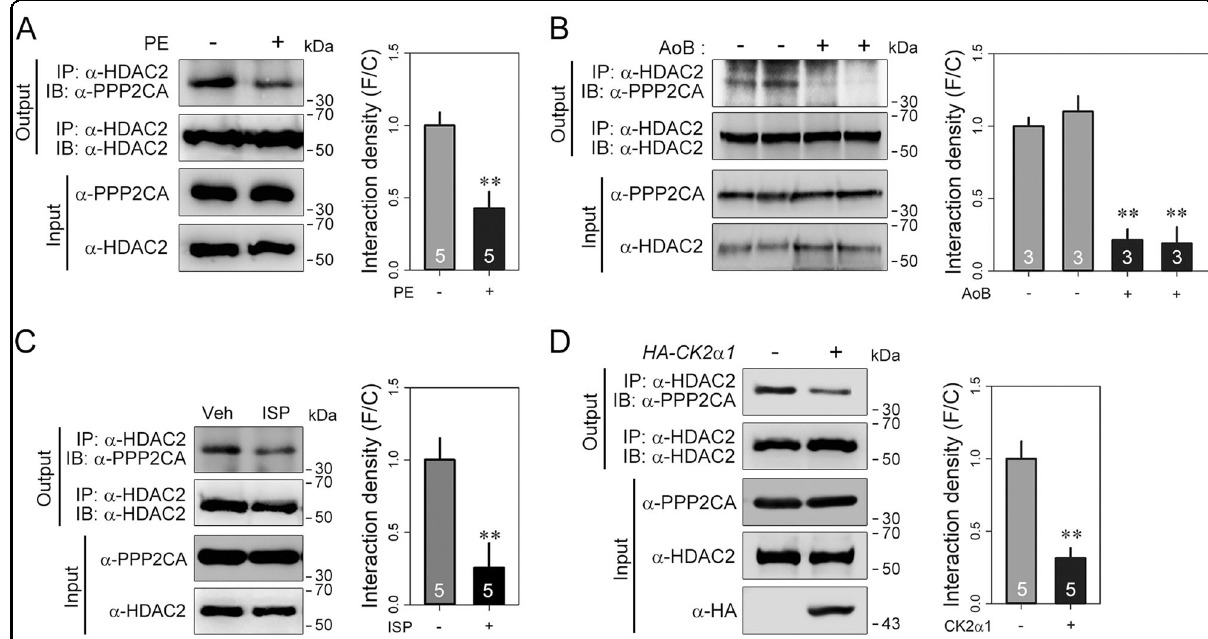
Fig. 3 PPP2CA dissociates from HDAC2 in response to hypertrophic stimuli. The binding of PPP2CA to HDAC2 was reduced by hypertrophic stresses ( a – c ). In cardiomyocytes stimulated with 20 μ mol/L PE, the interaction between HDAC2 and PPP2CA was decreased ( a ). Cardiac hypertrophy induced either by aortic banding (AoB) ( b ) or by isoproterenol (ISP, 30 mg/kg/day), a beta-adrenergic agonist, also provoked the dissociation of PPP2CA from HDAC2 ( c ). d To assess whether the hypertrophic stress-induced dissociation is HDAC2 phosphorylation-dependent CK2 α 1, an HDAC2 kinase was added to the immunoprecipitation assay. HDAC2 phosphorylation also detached PPP2CA from HDAC2. Data are presented as the mean ± SEM. ** p < 0.01. White numbers in each bar denote the independent set used for densitometer